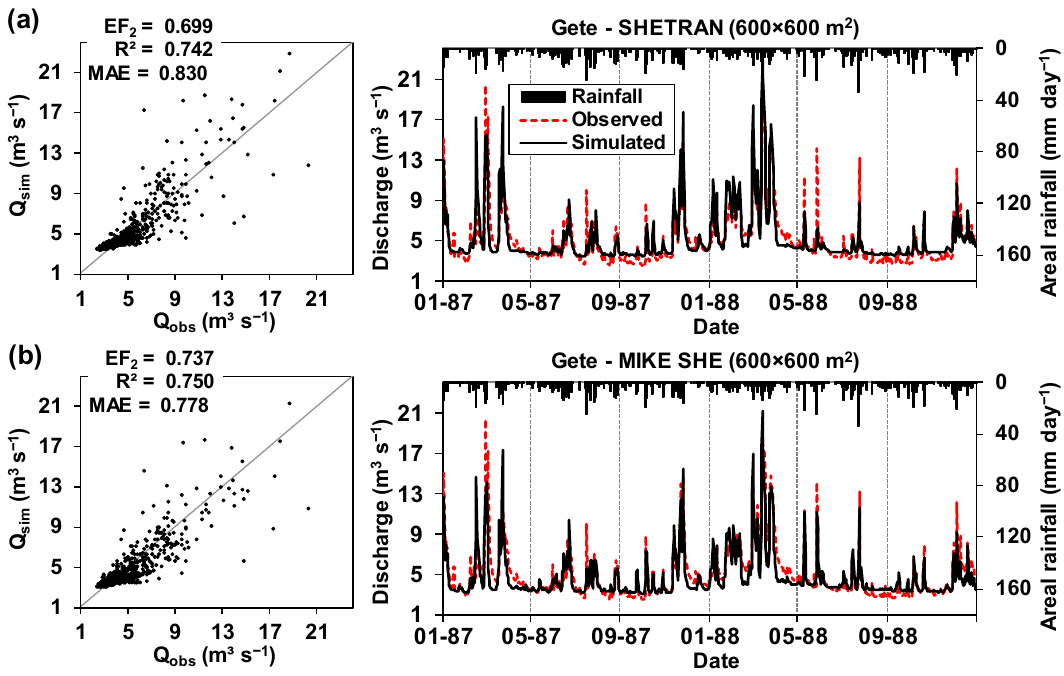
Figure 7. Scatter plots and hydrographs of total streamflow observed (Q obs ) and predicted (Q sim ) at the outlet of the catchment, for the validation period. Predictions were produced by ( a ) SHETRAN; and ( b ) MIKE SHE. EF 2 = Coefficient of Efficiency (Nash and Sutcliffe Efficiency); R 2 = square of the Pearson’s type (linear) correlation coefficient; MAE = Mean Absolute